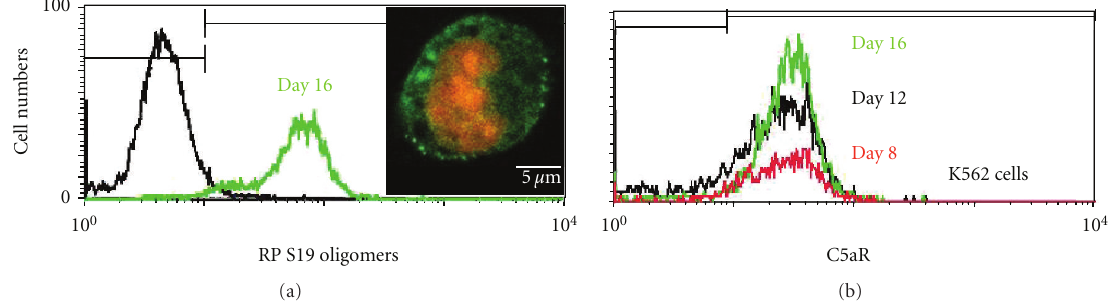
Figure 3: Generation of RP S19 oligomers and expression of the C5aR during the haemin-induced di ff erentiation of K562 cells under monocell culture conditions K562 cells were harvested at several time points after the haemin induction and were stained with anti-C5a rabbit IgG or anti-C5aR mouse IgG for the FACS and CLSM analyses ( n = 3).